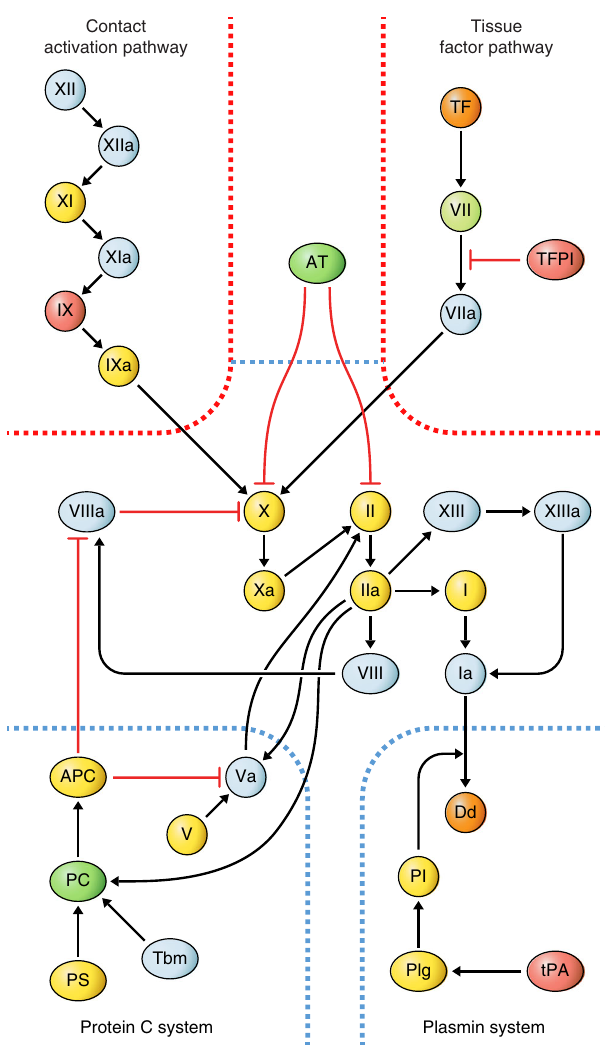
Fig. 4 Association of coagulation system components with development of heart failure. Diagram of protein interactions in the coagulation system based on a published review 60 . The two activation pathways (red borders) lead to activation of factor X which further activates II (thrombin) and subsequently fi brin and XIII, which form the bloodclot. The bloodclot is digested into d-dimers by the plasmin system, and three additional systems (blue dashed borders) negatively regulate clotting (protein C, AT, TFPI). Directionality of nominally signi fi cant associations ( p < 0.05) with incident heart failure (HF) from Cox proportional hazards regression models adjusting for age and sex ( n = 583 population-representative controls, 185 cases) is indicated for each component with color codes, where red indicates higher concentration with incident HF, green lower concentrations, and yellow no signi fi cant association. Nominally signi fi cant associations ( p < 0.10) are indicated in orange for higher (two components) and mint green for lower (one component) concentration. All associations were examined only after exclusion of subjects on oral anticoagulation therapy (warfarin). White color indicates that the component was not present on the aptamer- based proteomics platform. APC activated protein C, AT antithrombin III, Dd d-dimer, PC protein C, Pl plasmin, Plg plasminogen, PS protein S, Tbm thrombomodulin, TFPI tissue factor pathway inhibitor, TF tissue